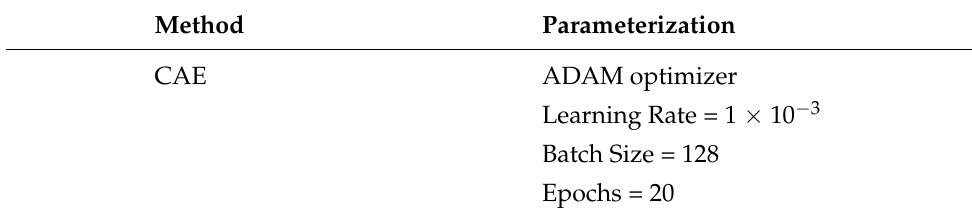
Table 3. Training parameters for Class-expert CAEs.